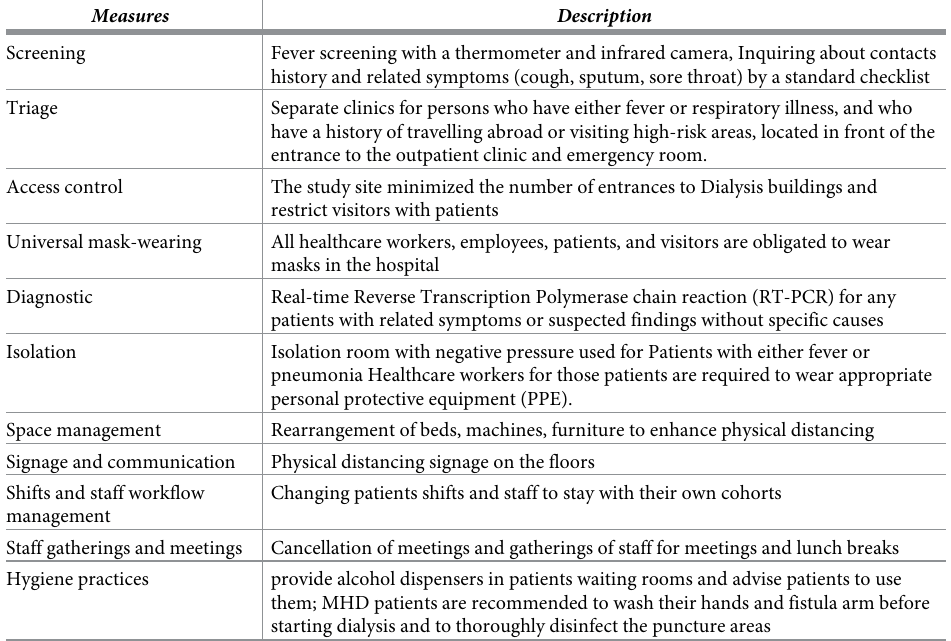
Table 2. Key infection mitigation measures used in the dialysis